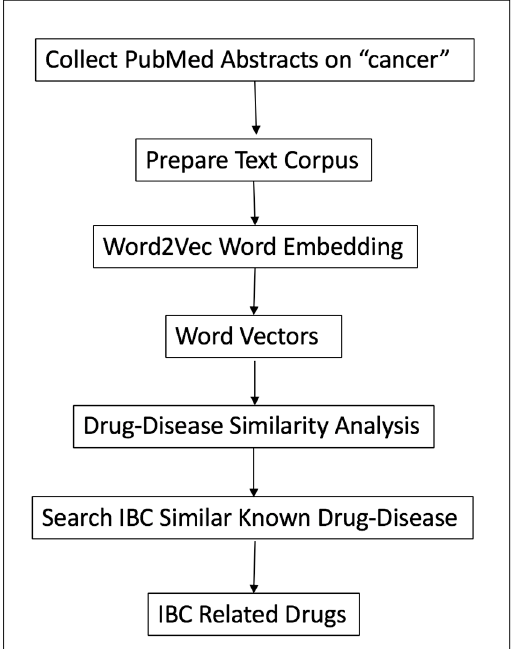
Figure 5. The Literature-Wide Association Studies (LWAS)-IBC drug repurposing workflow.